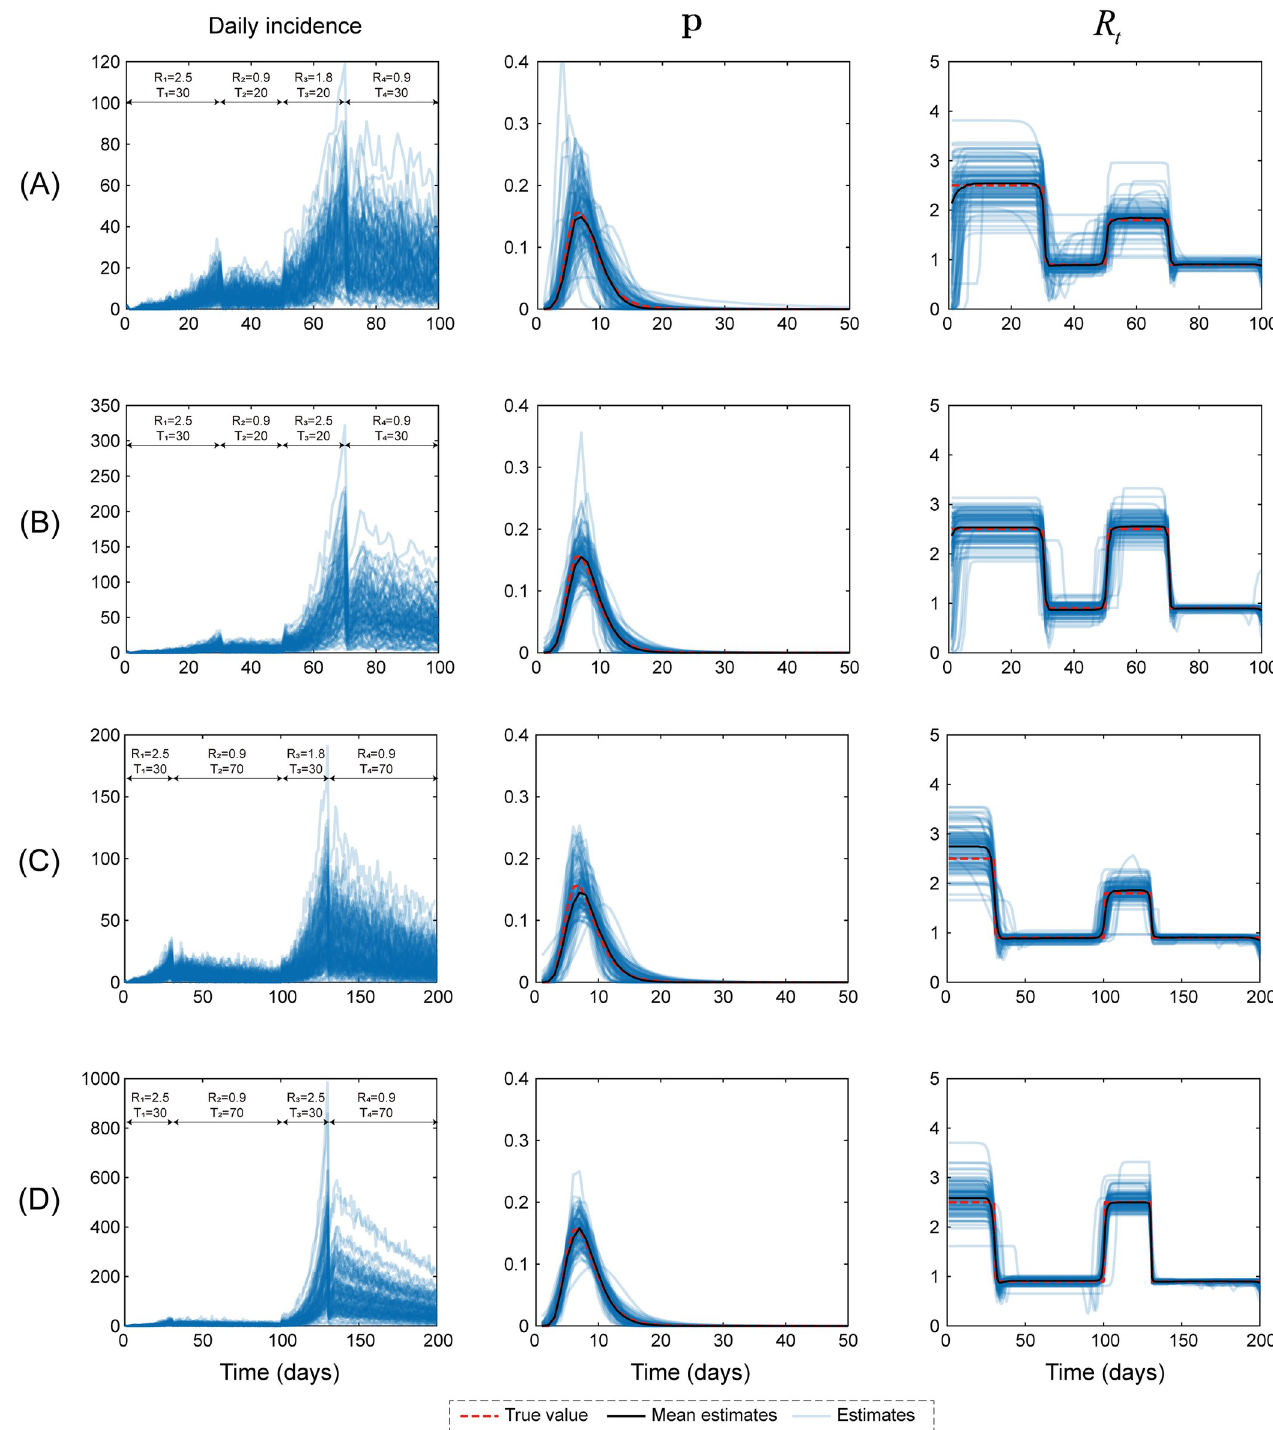
Fig 6. A total of 100 trials were conducted to further verify the performance of our method in scenario two. Simulations were performed based on the assumptions that the number of initial cases was 2 and the serial interval exhibited a lognormal distribution with a mean and variance of 8 and 9, respectively. Each epidemic was split into four stages, and R 1 − R 4 and T 1 − T 4 are key parameters that determine the epidemic severity and end time, respectively. The left, middle and right panels present the daily incidence and estimates of the serial interval and instantaneous reproductive number, respectively. The blue lines show the estimates, and the dark lines denote their mean values after 100 simulations. The red dashed lines represent the ground truth.